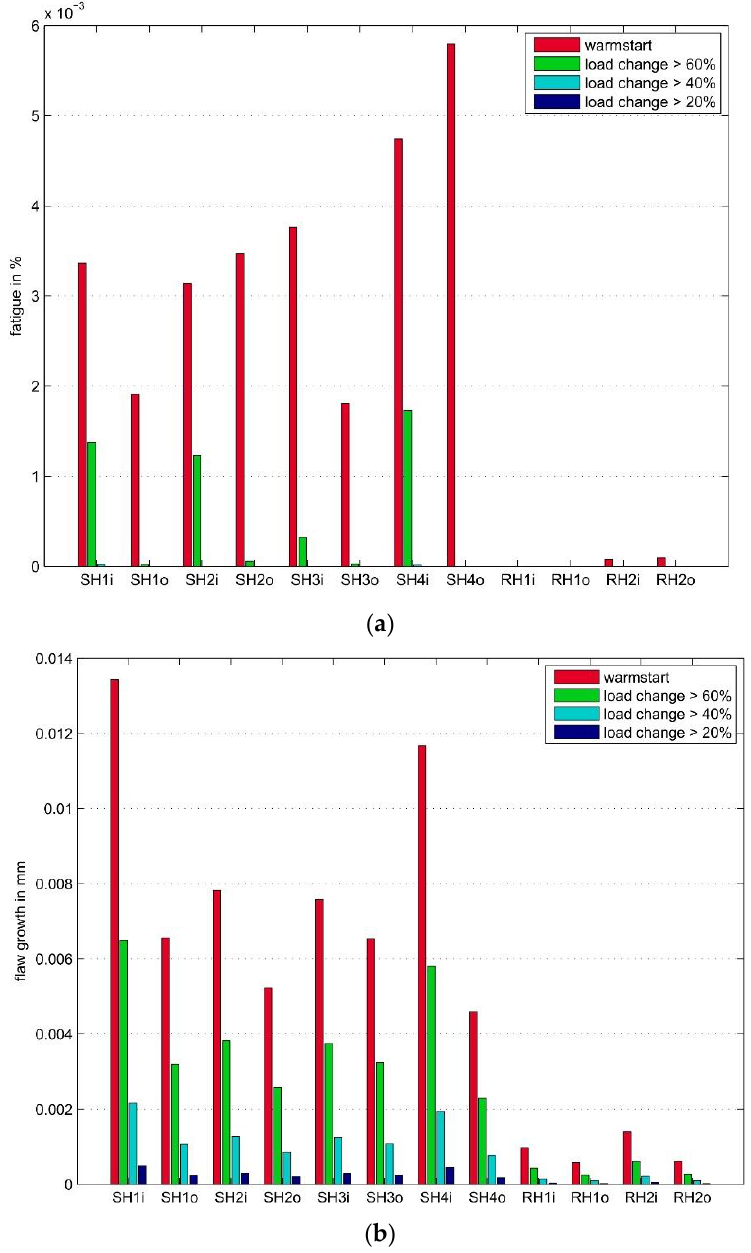
Figure 13. For different base stress situations and heating surfaces inlet and outlet headers (SH1/2/3/4: superheater 1/2/3/4, RH1/2; reheater 1/2, i: inlet, o: outlet): ( a ) Fatigue; ( b ) Flaw growth in potentially pre-damaged thick-walled headers; Reprint with permission [90]; 2011, LiU Electronic Press.